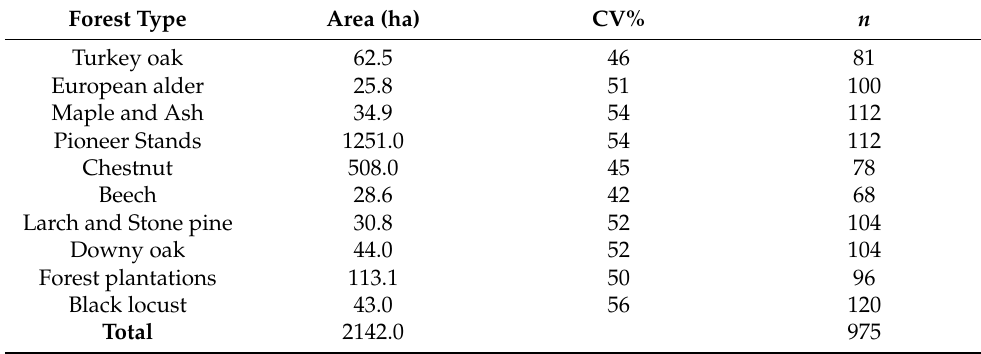
Table 4. Forest types in AOI as mapped by